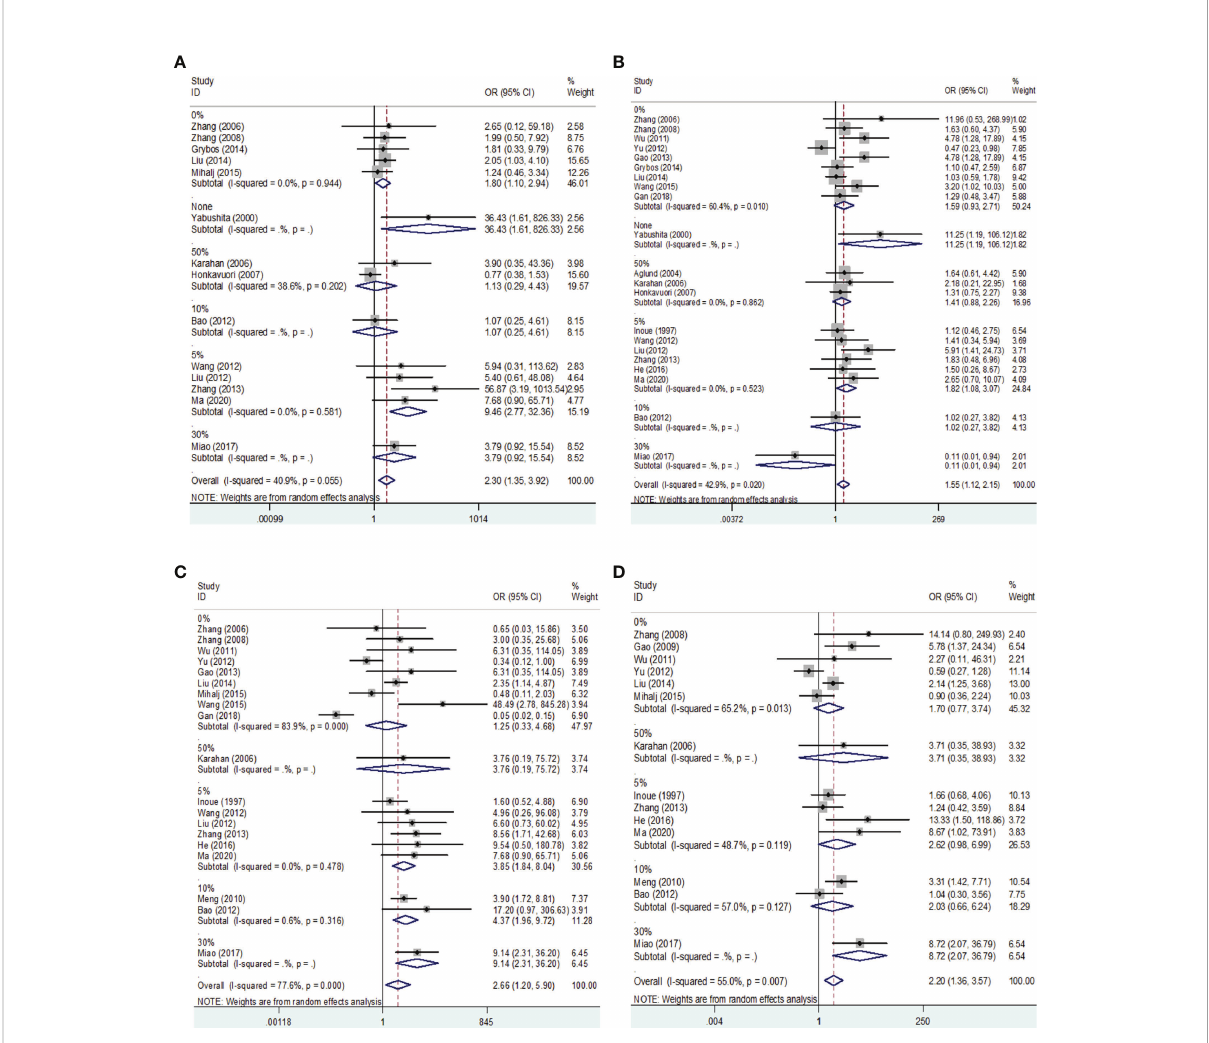
FIGURE 4 Forest plots for the associations of MMP-9 overexpression with clinical features of EC in different cut-off values of IHC. (A) Forest plot for FIGO stage of EC. (B) Forest plot for endometrial tumor grade. (C) Forest plot for lymph node metastasis of EC. (D) Forest plot for myometrial invasion of EC. IHC, immunocytochemistry. OR, odds ratio; EC, endometrial cancer.